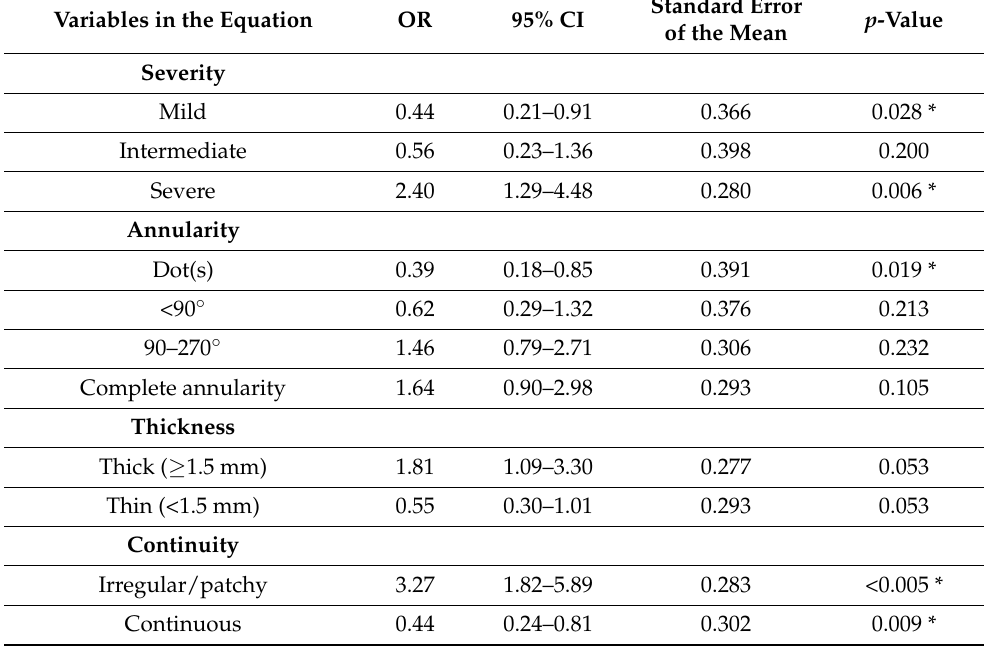
Table 3. Multivariate logistic regression analysis was performed to determine the different calcifica- tion characteristics in the femoropopliteal arteries correlated to age-matched non-PAD (n = 83) and CLI patients (n = 116). The patients without calcifications were excluded from this analysis. Variables in the